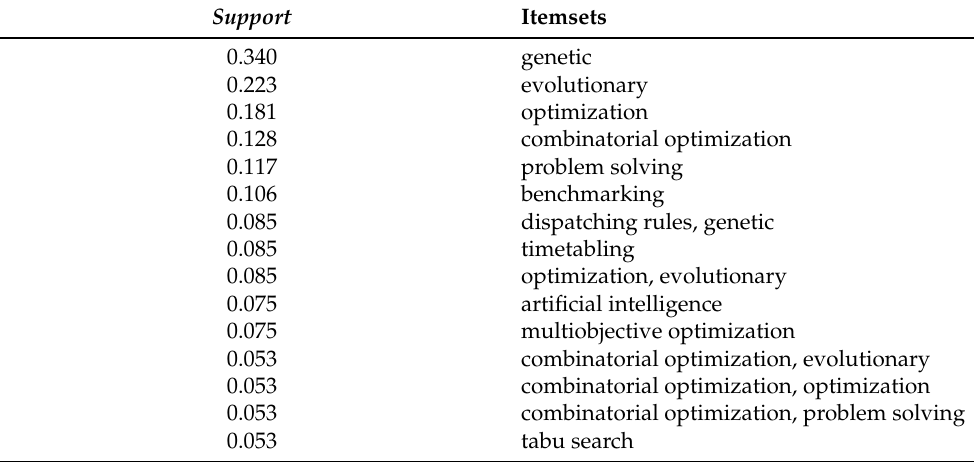
Table 3. Apriori’s most-related words and their corresponding support value using index keywords.